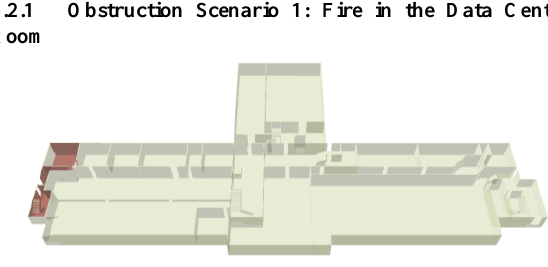
Figure 20. Obstruction Scenario in the Data Center Room